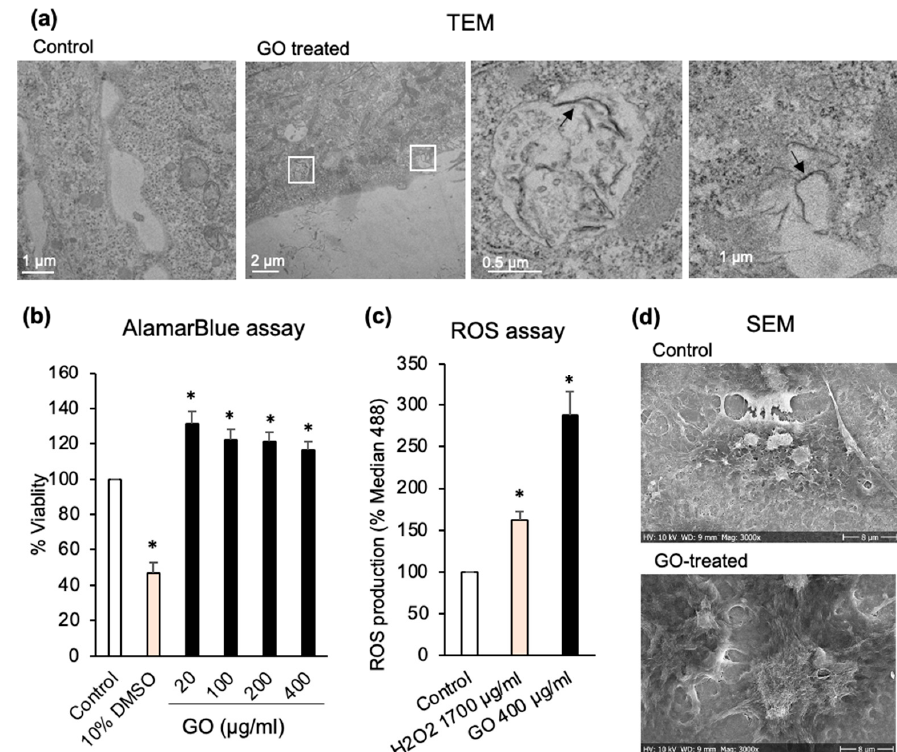
Figure 2. GO alone induces ROS generation in Huh7 cells, which leads to a small decrease of cell viability upon longer exposure. ( a ) TEM images of Huh7 control cells and cells treated with 400 μ g/mL of GO for 6 h. Evidence of GO internalization is marked with white boxes, with higher magnification images and black arrows pointing to internalized GO flakes. ( b ) AlamarBlue cell viability assay 24 h after administration of different concentrations of GO. All values are normalized to those obtained for untreated cells (medium alone). The positive control was 10% DMSO. ( c ) ROS production induced by 400 μ g/mL of GO after 24 h of treatment, measured at excitation at 488 nm on a flow cytometer based on the formation of the fluorescent compound 2 ′ ,7 ′ -dichlorofluorescein (DCF) in presence of ROS. Median 488 values represent DCF fluorescent signal and are normalized to the signal from untreated cells. H2O2 was used as a positive control. ( d ) SEM images of Huh7 cells treated with 400 μ g/mL of GO for 24 h. Untreated cells are shown as control. Relevant to panel B and C, data represent the mean ± SE of three independent replicates and it was statistically analyzed and compared with the control (* p < 0.05) using Student’s t test.